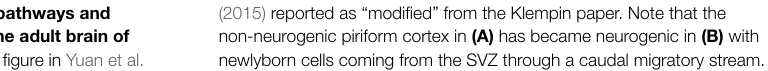
FIGURE 1 | Schematic representation of olfactory pathways and relative neurogenic and non-neurogenic areas in the adult brain of rodents. (A) Original figure by Klempin et al. (2011); (B) figure in Yuan et al.